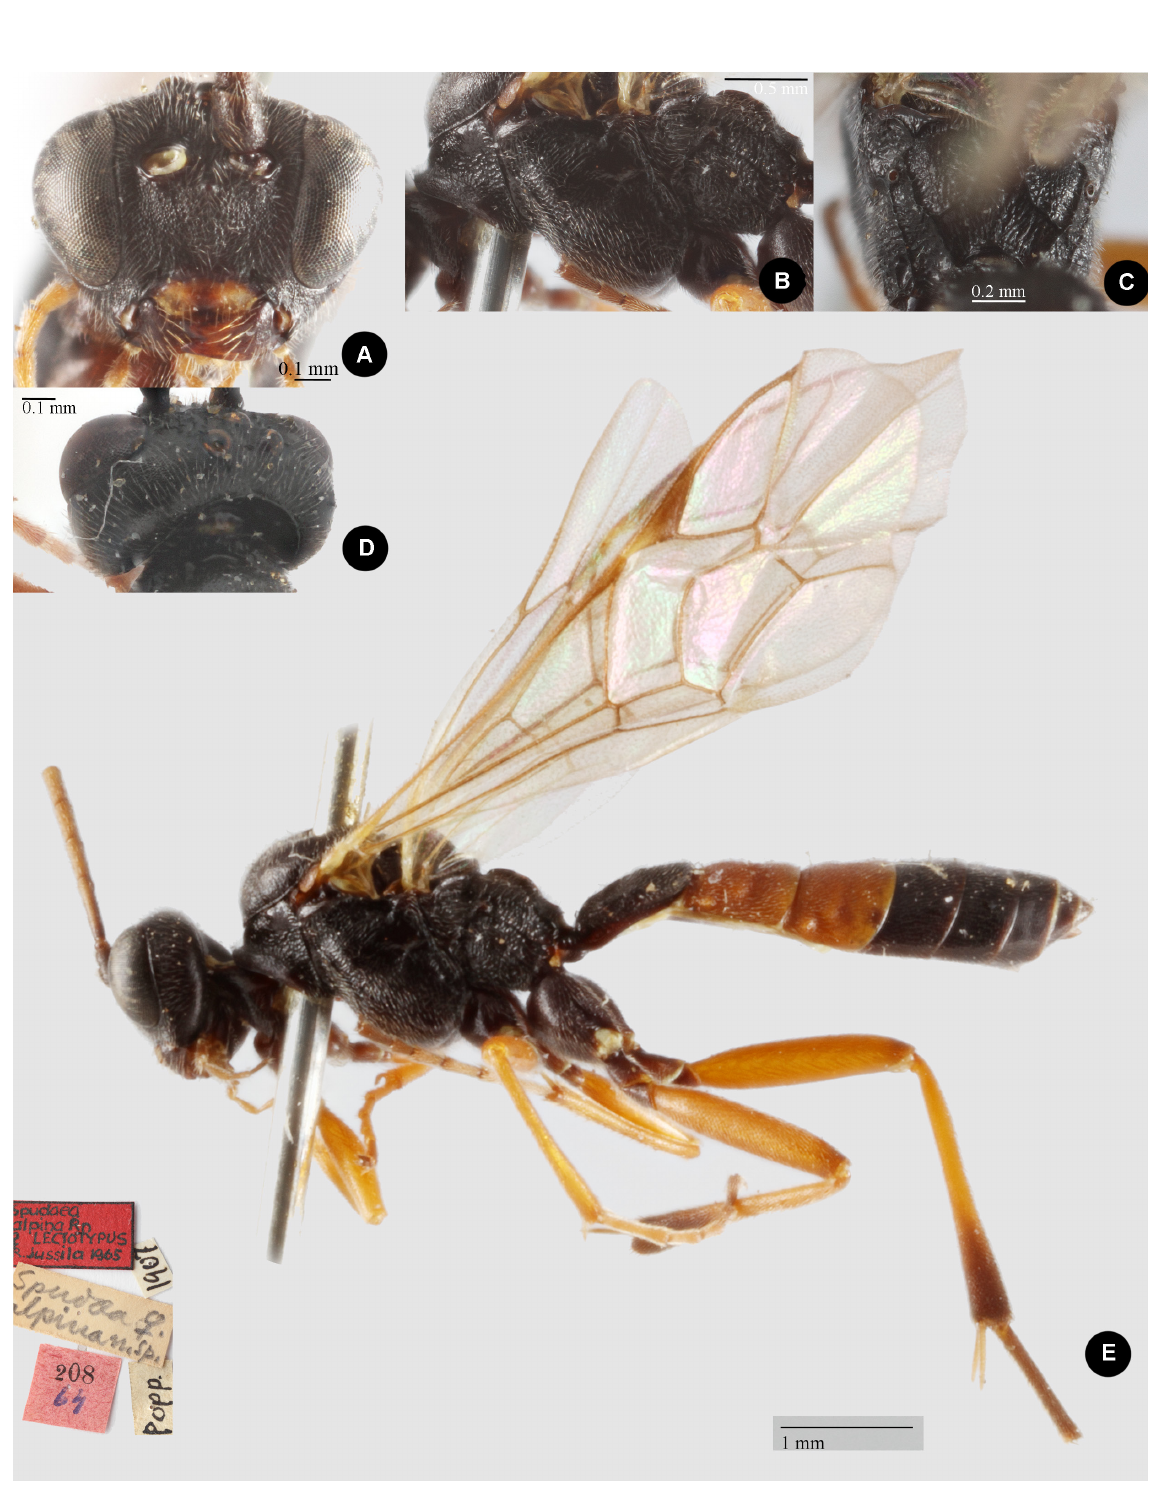
Fig. 3. Rhinotorus alpinus (Roman, 1909), lectotype, ♀. A . Face. B . Mesopleuron. C . Propodeum. D . Head dorsally. E .